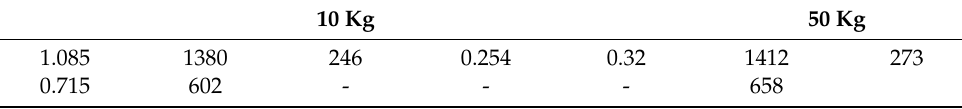
18 of 21 Table 4. Energy-balanced travel based on the Gini coefficient. Scenario 3: Effect of Ground Friction and Load Change . The application, which was carried out on stone ground, was repeated on earthy ground. Table 5 shows the changes. Table 5. Effect of ground friction. Stone Ground